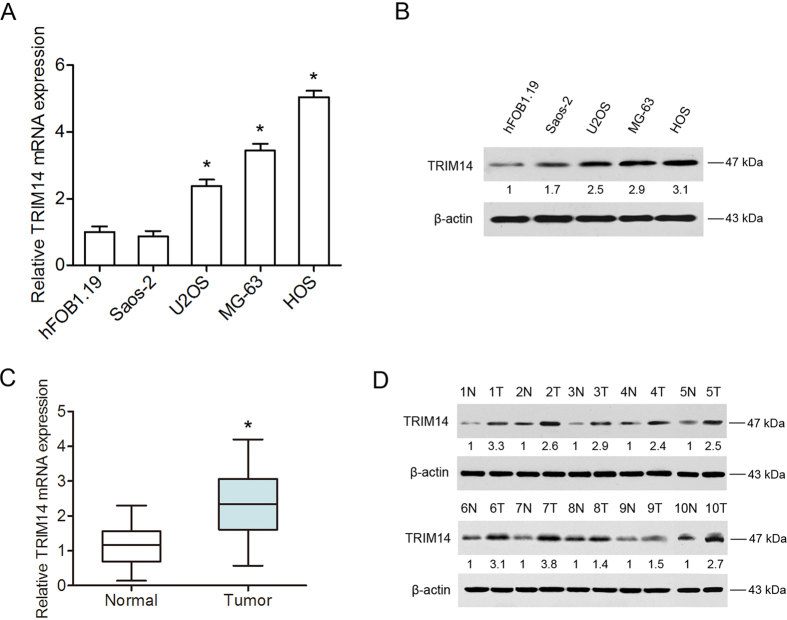
TRIM14 is highly expressed in human osteosarcoma tissues and cell lines.(A) TRIM14 mRNA and protein expression in human osteosarcoma cell lines and the normal osteoblastic cell line, hFOB 1.19, detected using qRT-PCR and western blot (B), respectively. The numbers below the blots show densitometric values that are corrected for loading. (C) TRIM14 mRNA expression in 45 osteosarcoma specimens and adjacent normal bone tissues. (D) Western blot analysis of TRIM14 protein expression. *P < 0.05.